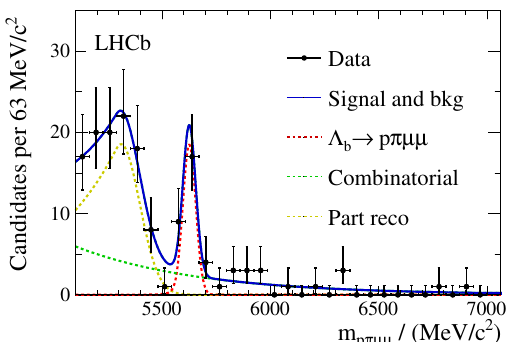
Figure 3 . Mass distribution of (cid:3) 0 p(cid:25) (cid:0) (cid:22) + (cid:22) (cid:0) candidates compared to the result of the (cid:12)t. The b ! (cid:12)t parameterisation is described in the text.